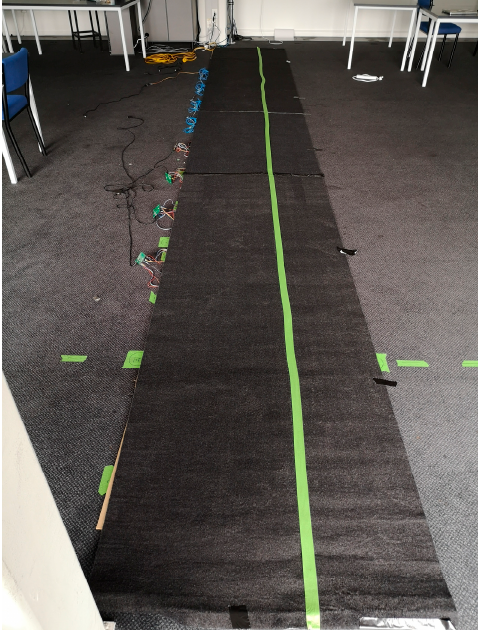
Figure 4. Eight sensing floor panels with carpet installed above forms the testbed the subjects walked on.